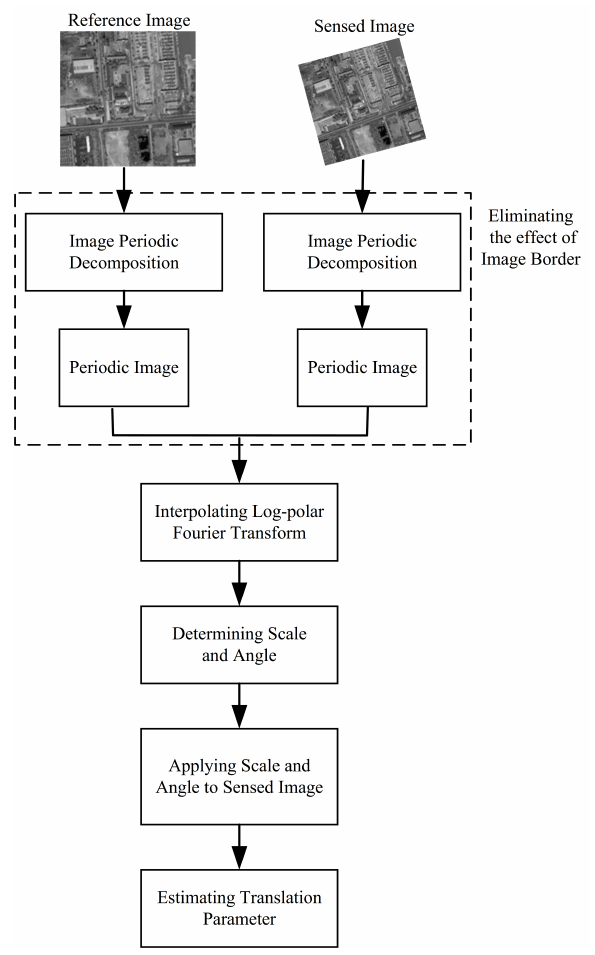
Figure 4. Overall workflow of the image registration based on phase